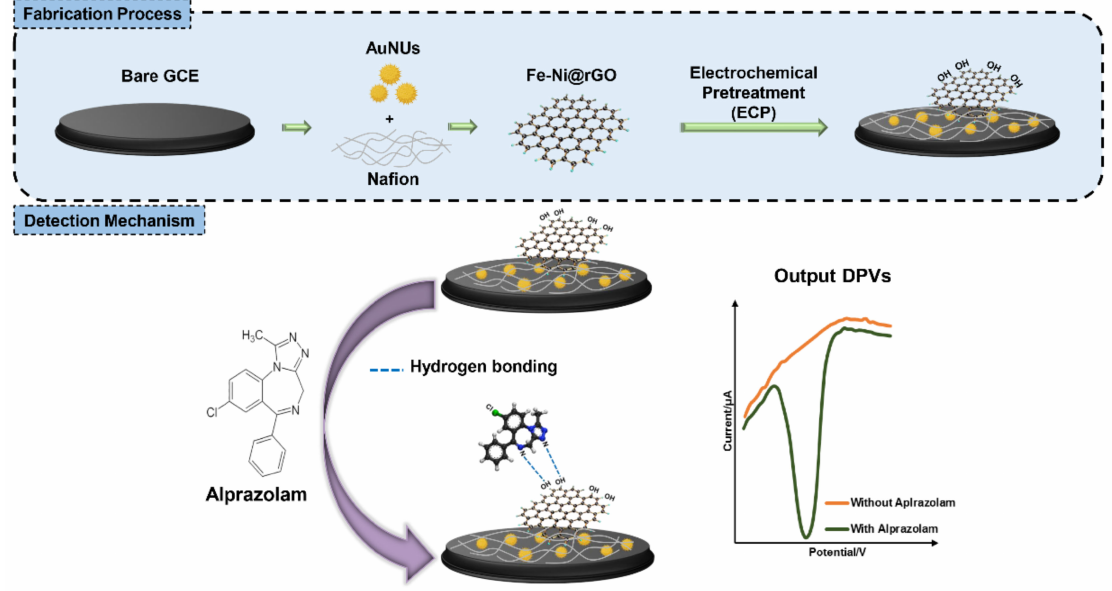
Figure 1. Schematic of the fabrication and measurement of the electrochemical nanobiosensor for alprazolam (Xanax)